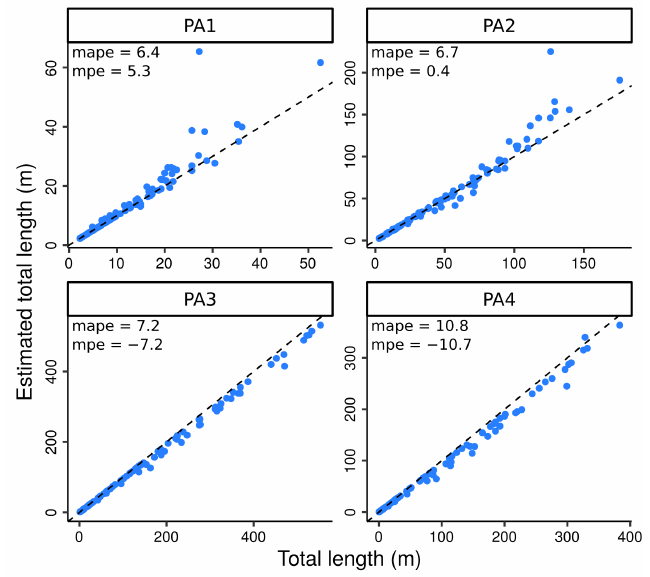
Figure 10. Total length of the annual shoots of each physiological age (PA) classified with the annual shoot segmentation model as a function of the the total length observed in the output file of the AMAPsim model for the corresponding PA; 110 trees were simulated at different ages ranging from 5 to 15 years (10 trees per age). The dotted line represent the 1:1 relation. The Mean Absolute Percentage Error (mape, %) and Mean Prediction Error (mpe) are indicated on the graphs.